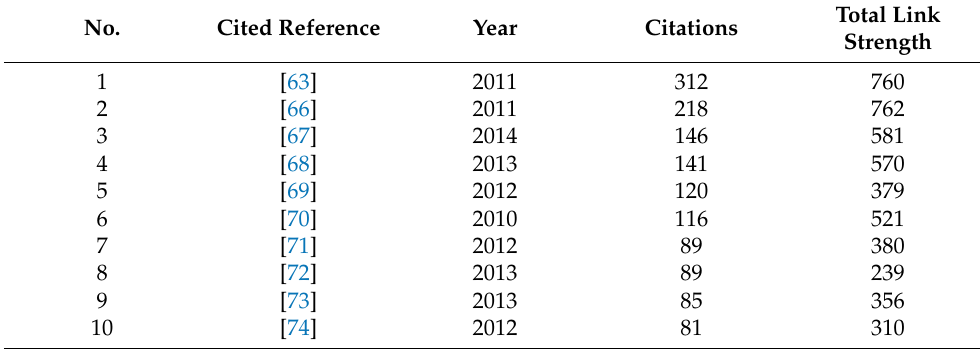
Table 7. The ten most influential papers in the studied